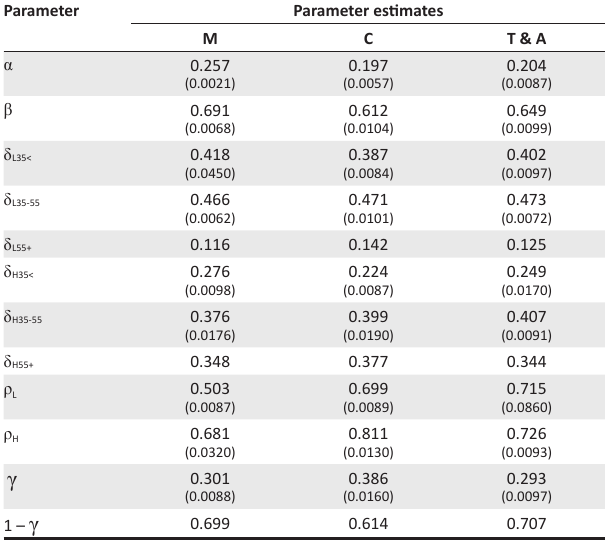
TABLE 1: Estimation results for the distribution and substitution parameters when the labour input is differentiated by age and skill level.